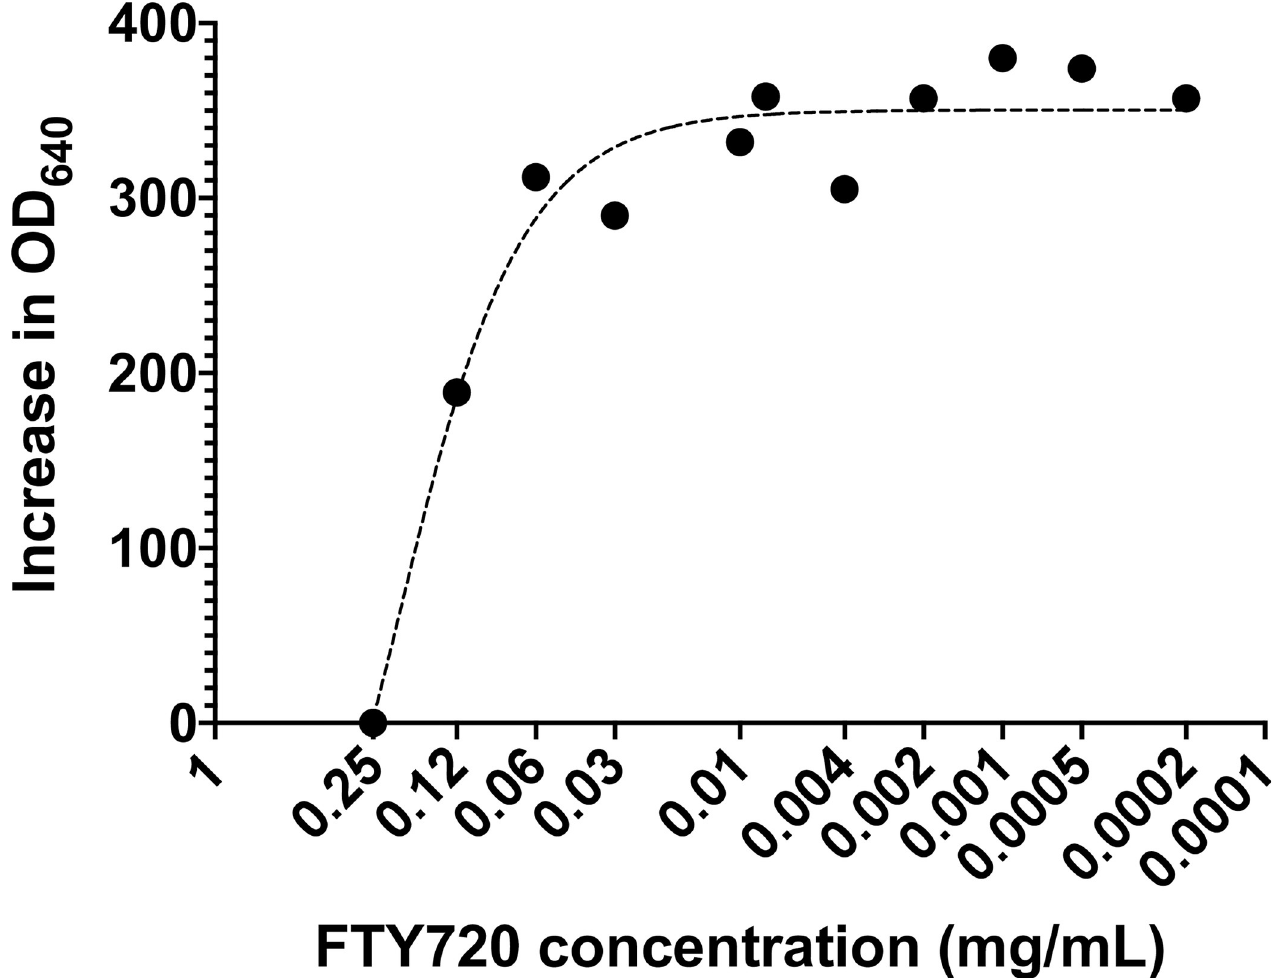
Fig 3. Results of the broth microdilution assay for determining FTY720’s MIC for C . albicans . First, microtubes were filled with standard C . albicans preparations in SDB and serial concentrations of FTY720. Then, the background OD’s were measured at 640 nm and the microtubes were incubated for 24 hours at 37˚C. After that, the OD’s were measured again at 640 nm and the results were documented. The measures plotted on the Y-axis are resulted from subtracting the pre-incubation (background) OD’s from the post-incubation OD’s. The hyphenated line corresponds to the best-fit regression model. Abbreviations: MIC, minimum inhibitory concentration; SDB, Sabouraud dextrose broth; OD, optical density.